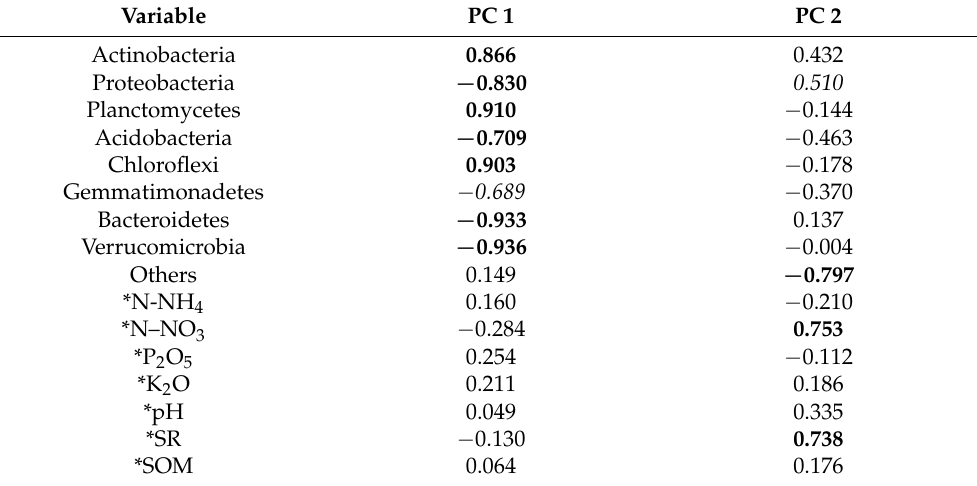
Table A2. Correlation matrix between principal components (PC) and variables (factor loadings